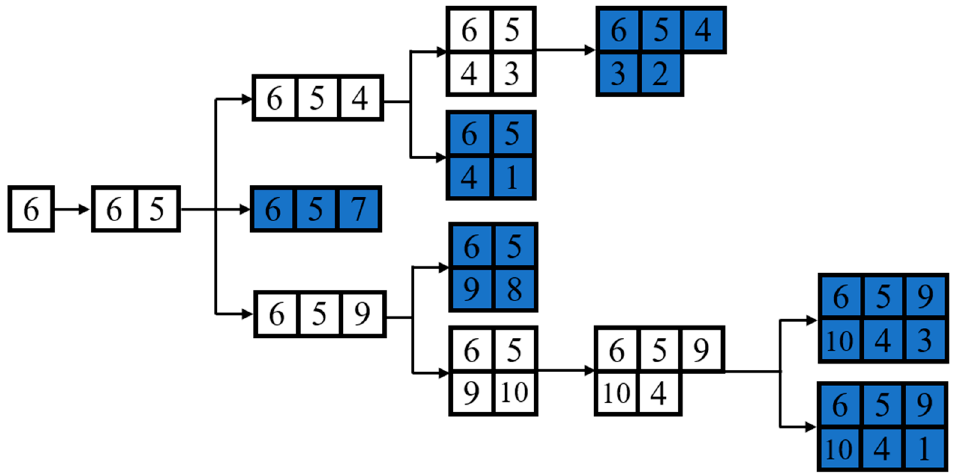
Figure 17. Schematic diagram of a search queue starting from node 6.